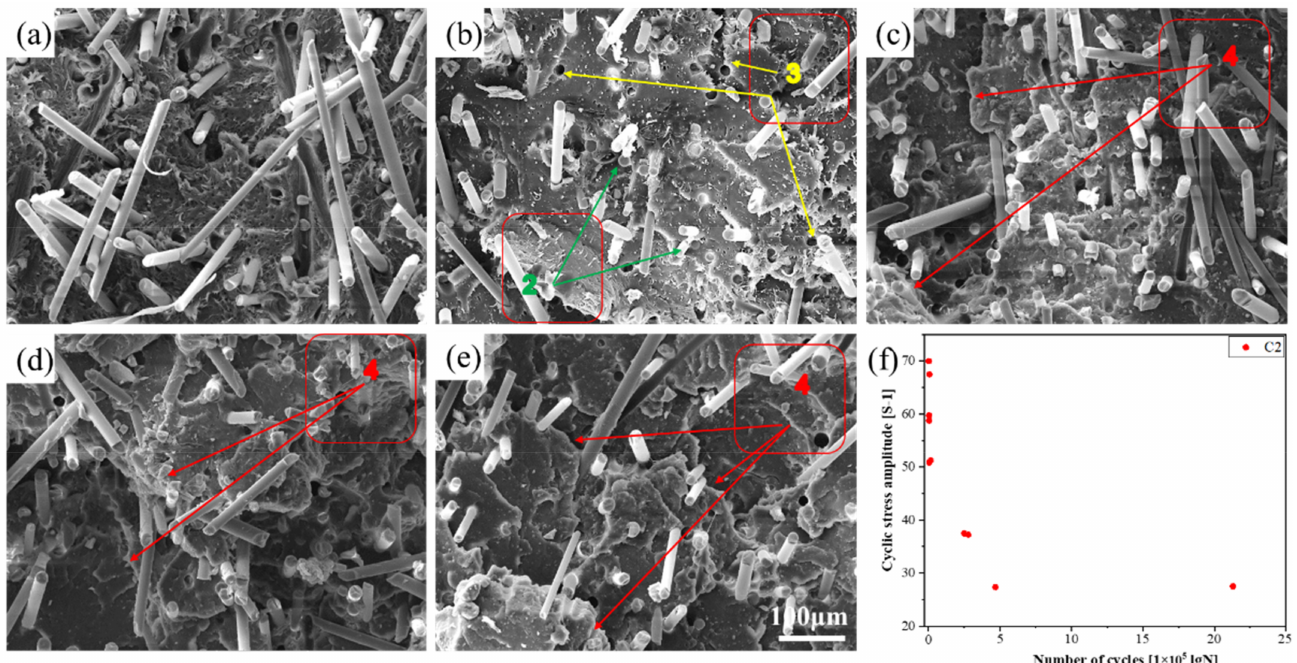
Figure 10. The fracture morphology and fatigue point of C2 at the following stress levels: ( a ) 30%, ( b ) 40%, ( c ) 55%, ( d ) 65%, and ( e ) 75%; and ( f ) fatigue point of C2 (area 2, fiber fracture; area 3, fiber pull-out; and area 4, layered peeling).